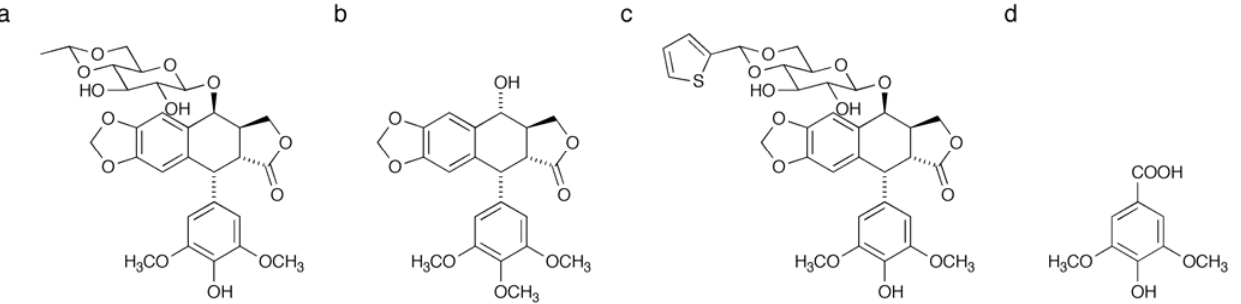
Figure 8. Structures of etoposide and its analogues used in this study: ( a ) etoposide; (b ) podophyllotoxin; ( c ) teniposide; ( d ) syringic